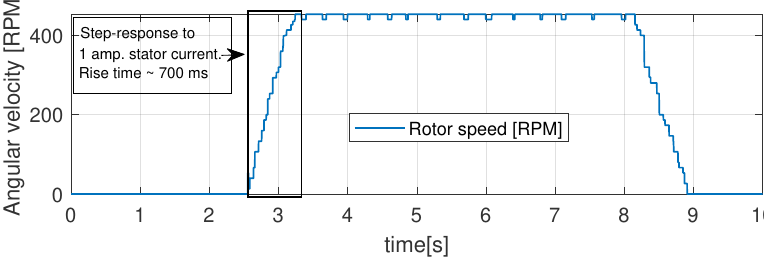
Figure 10. Rotor speed (experimental test III).